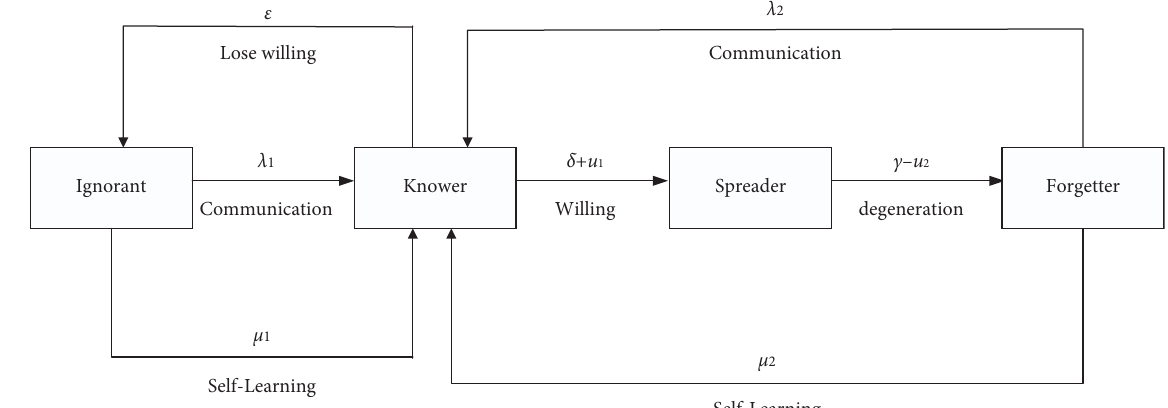
Figure 3: Schematic diagram of knowledge dissemination with